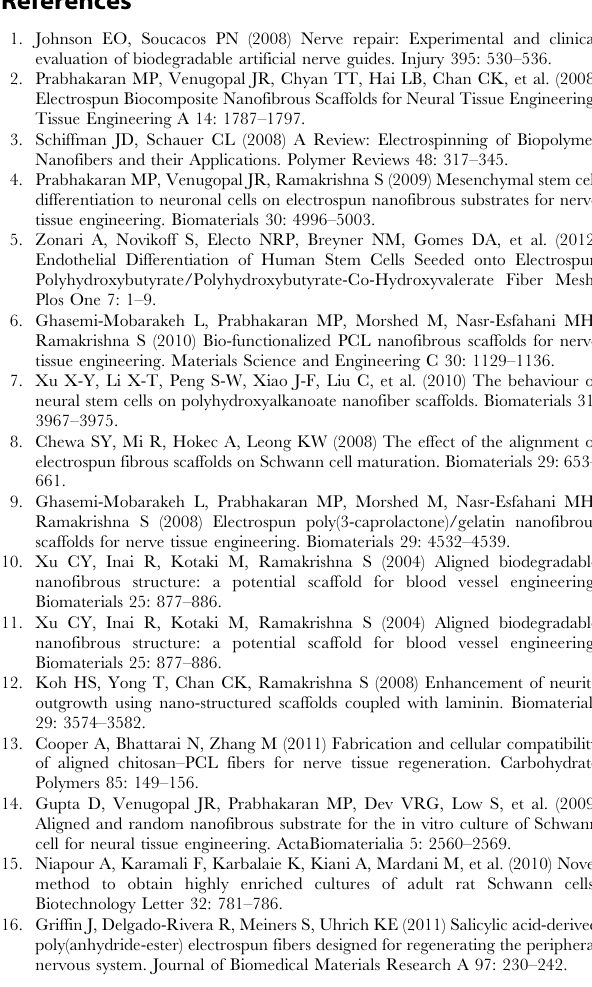
Figure S1 Variation of fiber diameters of PHB/PHBV nanofibers with polymer concentration and blend com- position. The voltage, flow rate and collecting conditions were fixed at 16 kV, 1.5 ml/h and 15 cm, respectively. Scaffolds prepared at 6% concentration were chosen for in vitro cell culture experiments. Figure S2 Tensile stress-strain curves of PHB, PHBV and PHB(50)/PHBV(50) random and uniaxially oriented nanofibers. Figure S3 SEM images of SCs on different PHB/PHBV electrospun solution blending nanofibrous scaffolds. (A) 1 day, and (B) 7 days after cell seeding. Scale bars represent 50 m m for top and 10 m m for bottom pictures, respectively. (TIF)